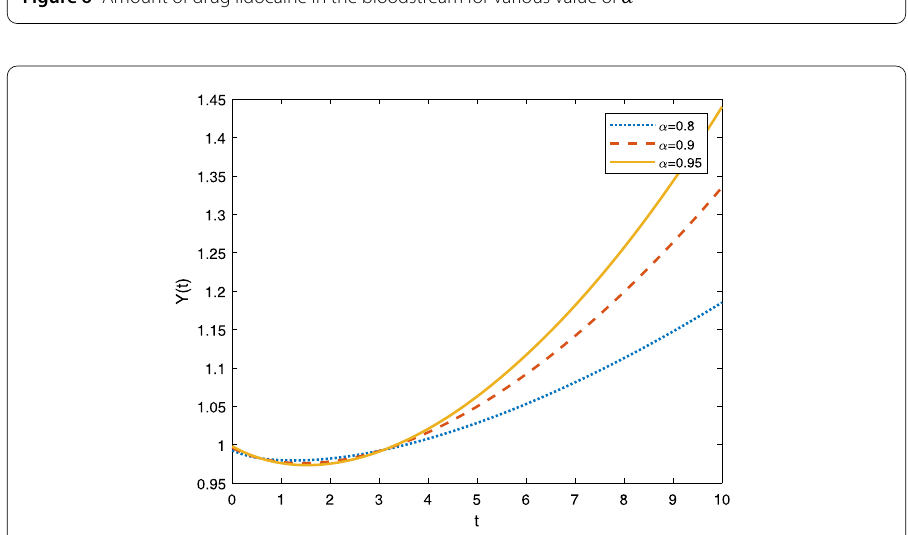
Figure 7 Amount of drug lidocaine in the body tissue for various values of